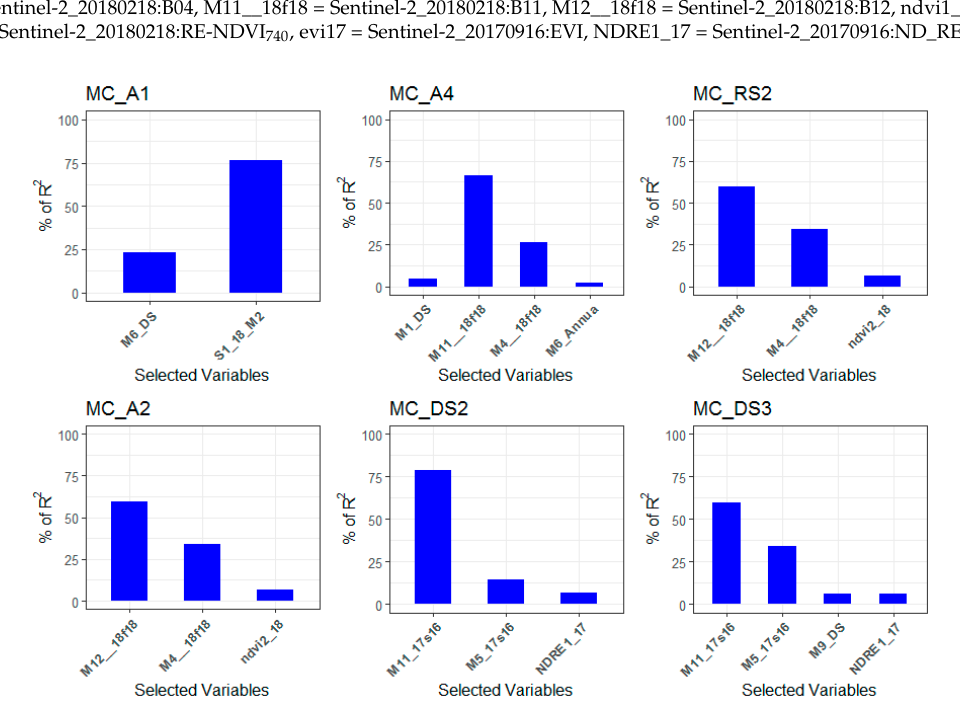
Table 6. Fitted models, selected variables from weighted mean approach (MW), Pseudo- R 2 , AIC, RMSE, and RMSEr.